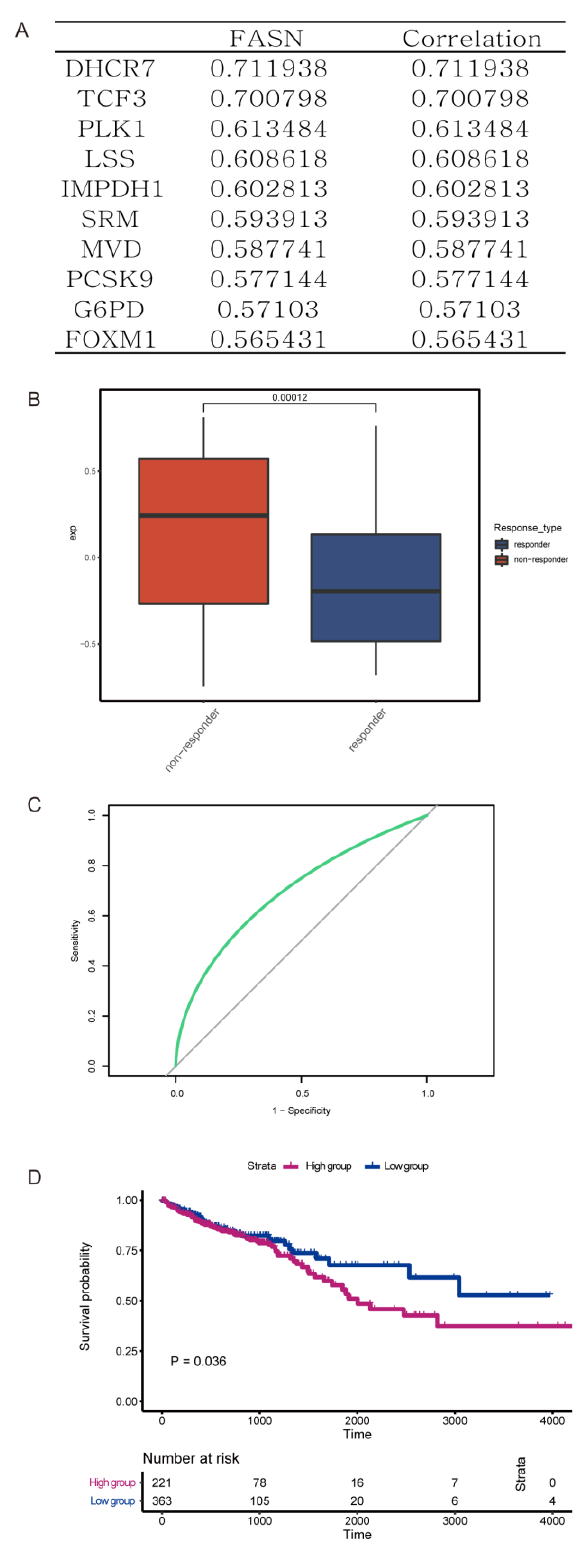
Figure 1. FASN biosynthesis correlates with progression and resistance to chemotherapy in CRC. ( A ) 10 crucial genes closely positively correlated with expression of FASN. ( B ) Compared with the response to oxaliplatin, expression of the FASN gene signature in those resistant to oxaliplatin was higher. ( C , D ) The ROC curve ( C ) and Kaplan – Meier overall survival curves ( D ) of patients with different levels of FASN gene signature ( p = 0.036, AUC = 0.696).